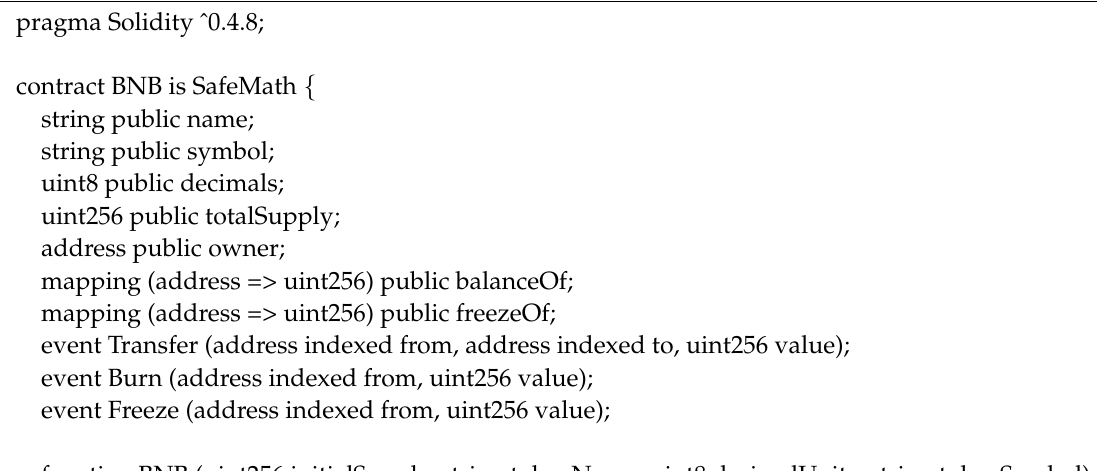
Algorithm A1 Partial source code of BNB contract. pragma Solidity